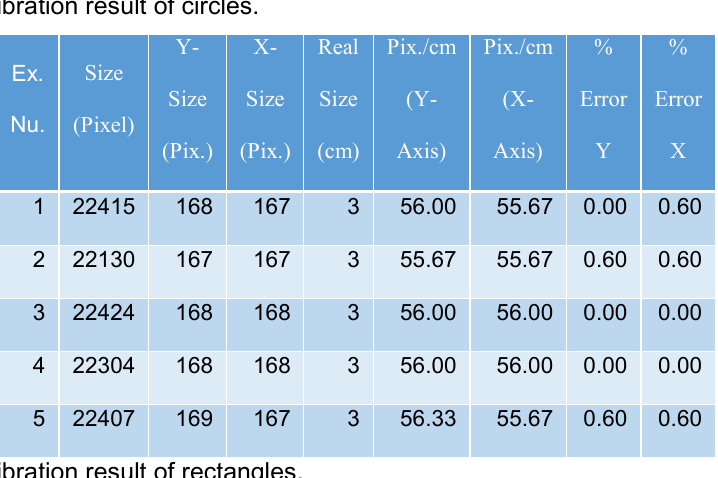
Table 2. The calibration result of circles.